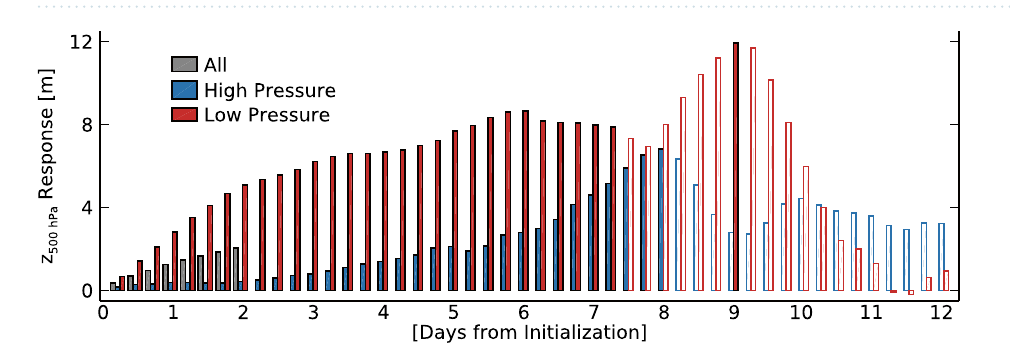
Figure 2. Evolution of the 500 hPa geopotential response over the Barents Sea region (70–80°N, 15–75°E) during the model integration time for all (gray), “high-pressure” (blue), and “low-pressure” (red) cases. Filled (blank) bars represent responses that are (not) significant based on a Student’s t test at the 99% confidence